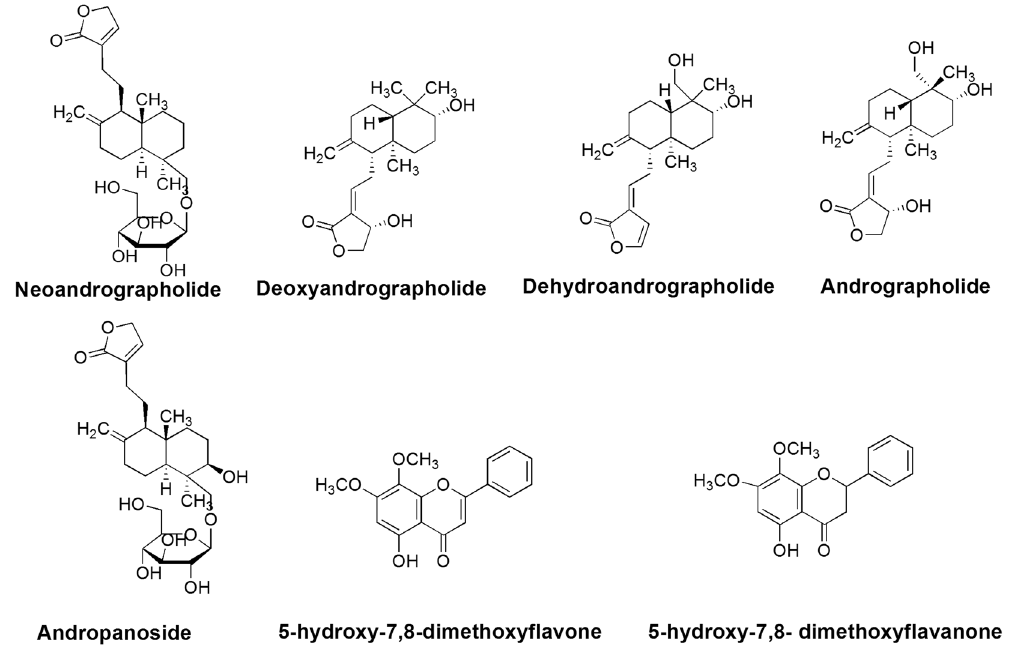
Figure 1. The structures of seven chemical constituents identified and quantified in absorbed AP